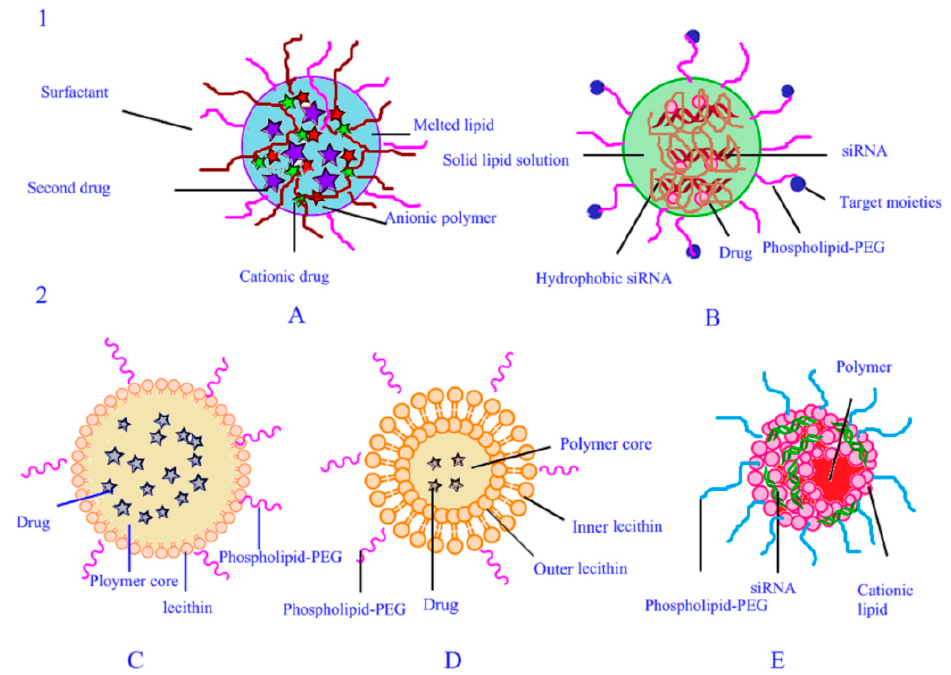
Figure 3. Schematic diagram illustrating the structure of PLNs. 1, monolithic matrix structure; 2, core–shell structure. ( A ) Monolithic matrix PLN with polymer–drug complex; ( B ) monolithic matrix PLN with siRNA–polymer complex; ( C , D ) core–shell PLN with drug in the core; ( E ) core–shell PLN with siRNA at the core–shell interface.